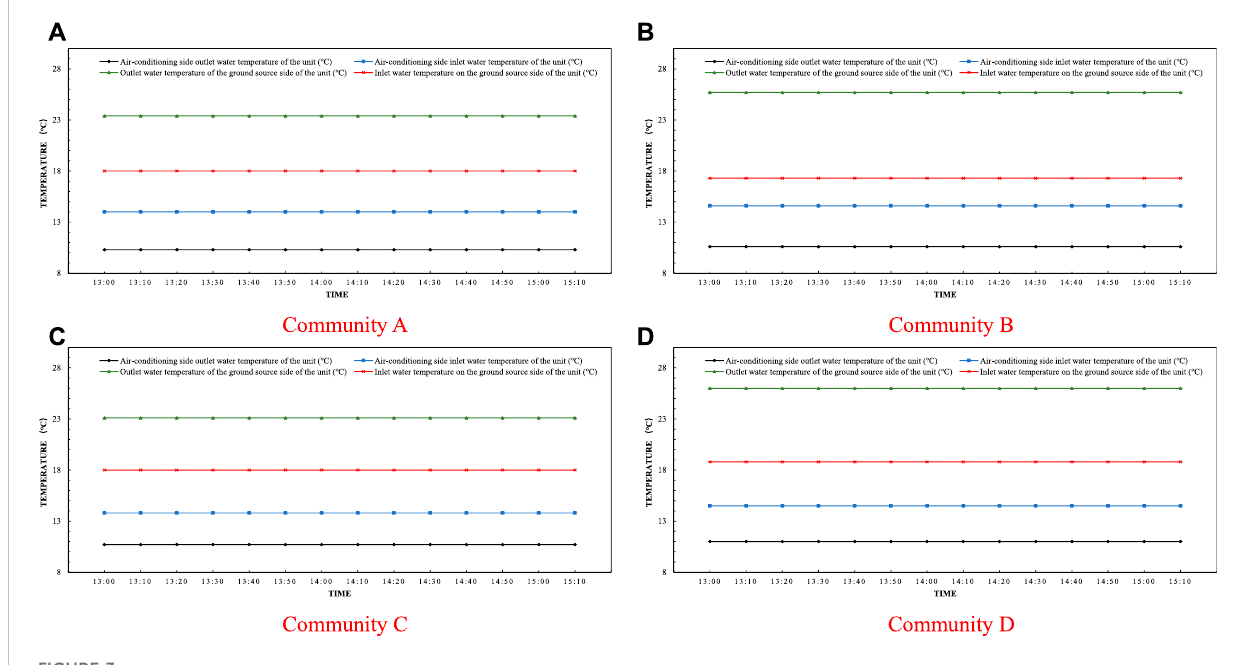
FIGURE 3 Temperature variation curves of circulating medium at ground-source-side and air-conditioning-side of heat pump unit. (A) Temperature variation curve for Community A; (B) Temperature variation curve for CommunityB; (C) Temperature variation curve for Community C; (D) Temperature variation curve for Community